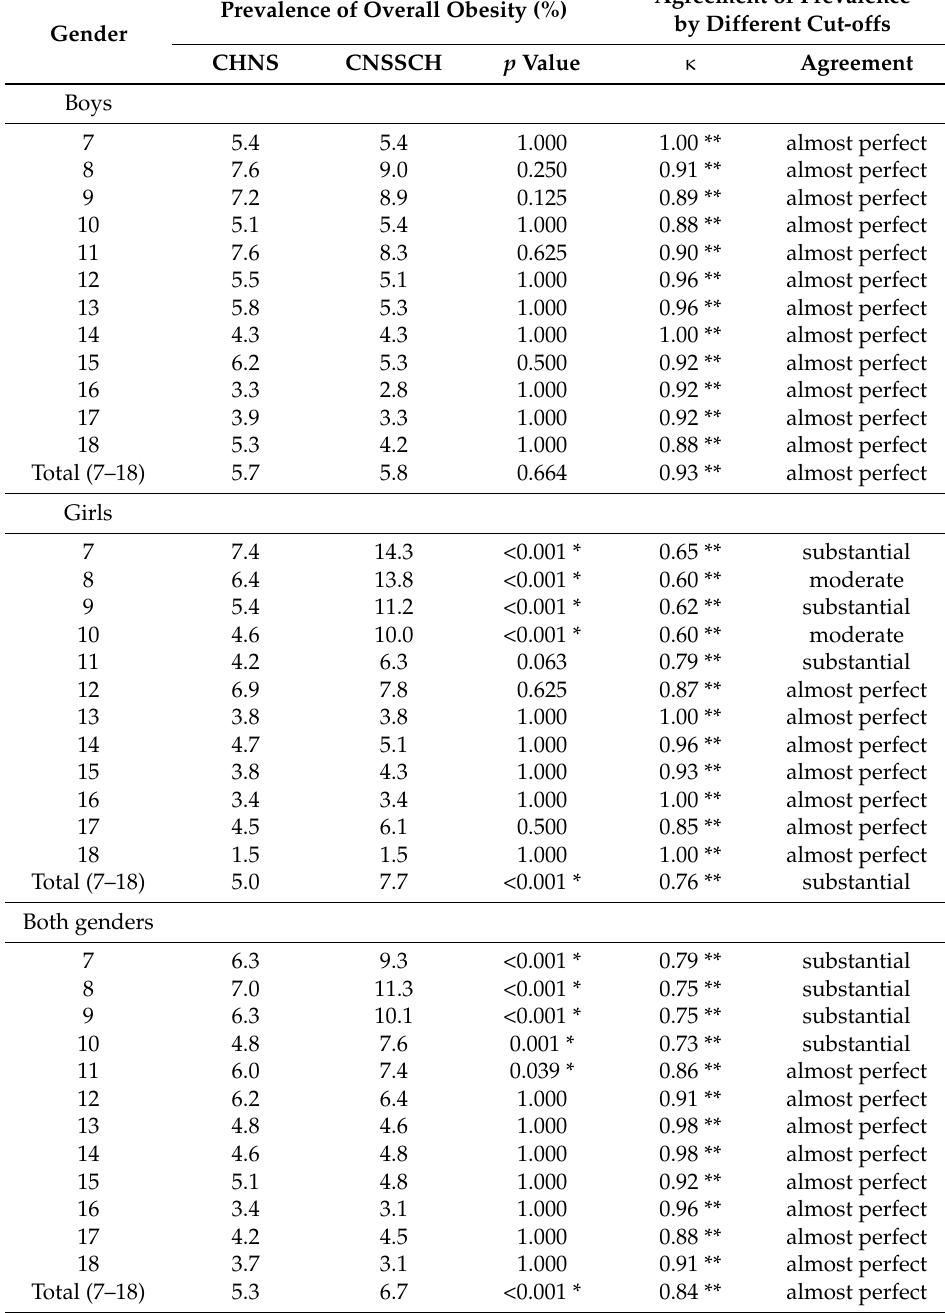
Table 4. Prevalence of overall obesity among Chinese boys and girls aged 7–18 years and the comparison based on the CHNS and CNSSCH